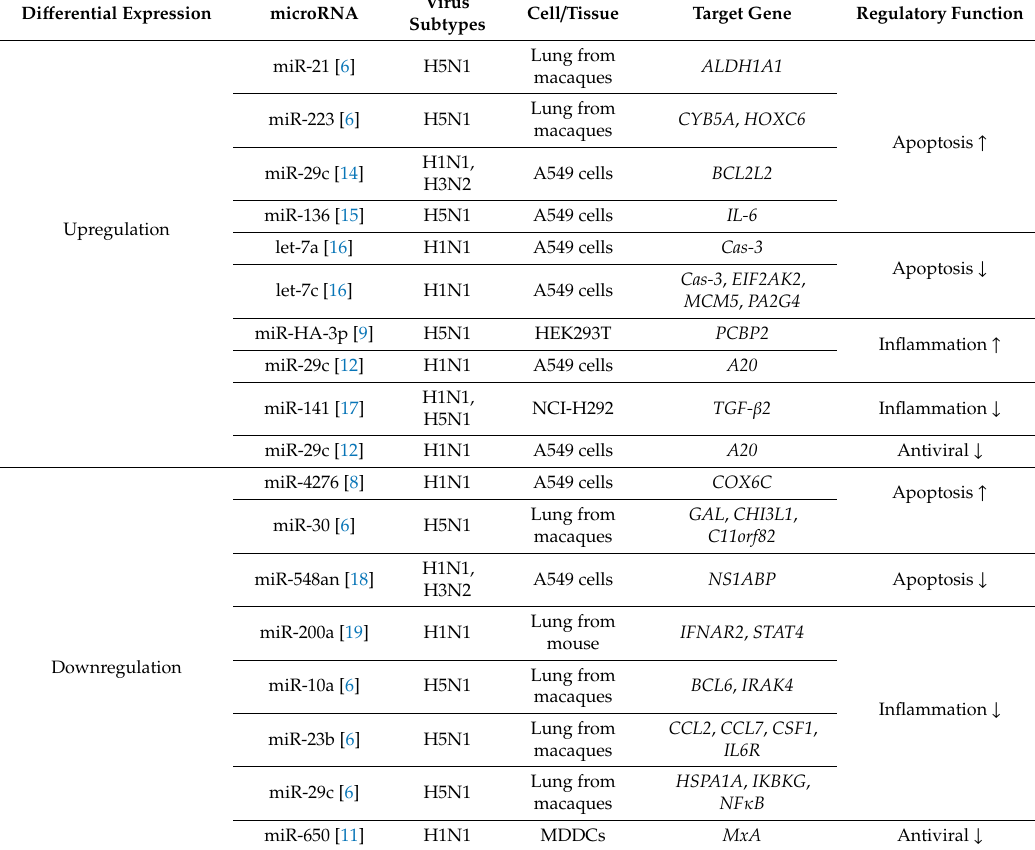
Table 1. List of major up- and down-regulated miRNAs in IAV infection that influence host